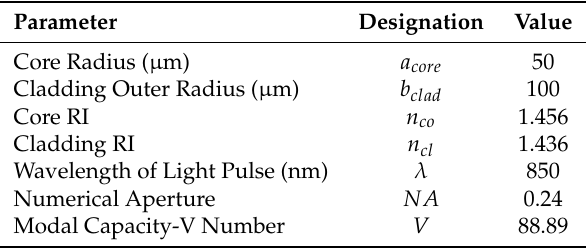
Table 3. Parameters characterizing the experimental waveguide fiber [15] to verify solution